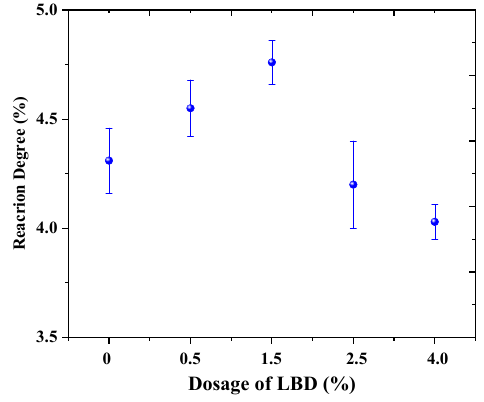
Figure 9. Reaction degree of LBD/OPC pastes.